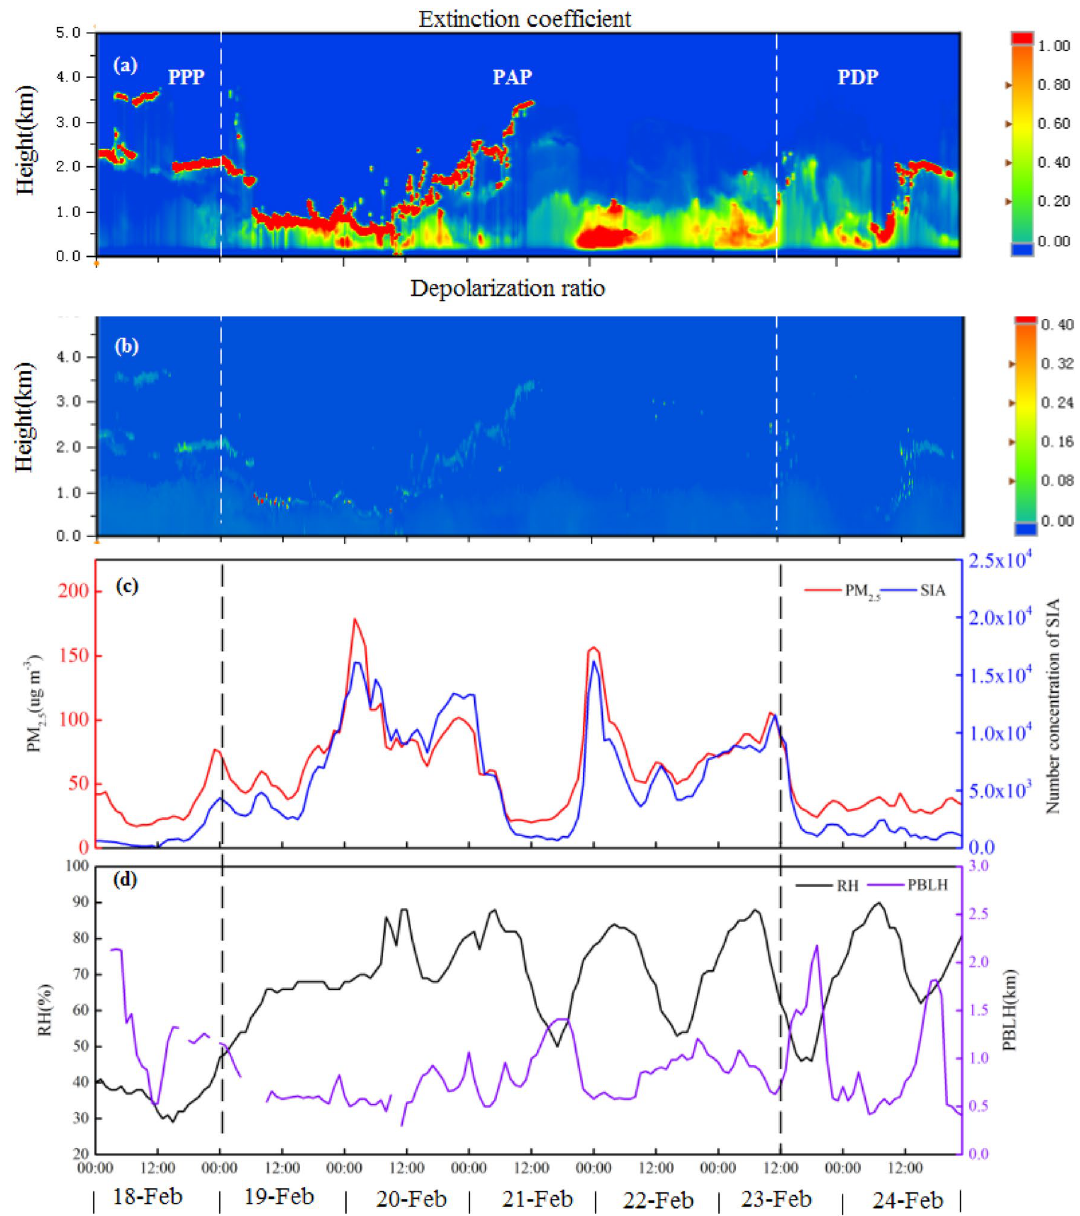
Figure 5. ( a , b ) The time series of the vertical distribution of the extinction coefficient and depolarization ratio of the lidar at 532 nm from February 18 to 24, 2020, respectively, and ( c ) is the time sequence diagram of PM 2.5 mass concentration and secondary inorganic particle number concentration in the same period. ( d ) is a diagram of RH and PBLH from February 18 to 24, reached peak values (179 μg/m 3 for PM 2.5 ). From 00:00, February 20 to 12:00, February 21, the PBLH was slightly uplifted, and wind speed increased. Then, the vertical diffusion conditions improved, and the level of pollut- ants consequently declined. Afterwards, the PBLH decreased, the wind speed decreased from 12:00 to 22:00 on February 21, and the PM 2.5 and SIA levels continued to increase, reaching their peaks. From 0:00 to 21:00 on February 22, the diffusion capability was relatively good, and PM 2.5 and SIAs decreased gradually; however, at 22:00, the near-ground distinction coefficient suddenly increased, and PM 2.5 and SIAs rose and reached a peak value again at 0:00 on February 23. Then, PM 2.5 and SIAs gradually decreased with atmospheric diffusion, and at 0:00 on February 23, the extinction coefficient rose again, while PM 2.5 and SIAs climbed slowly afterwards. Finally, in the PDP, the boundary layer was uplifted, the wind speed became stronger, and the overall atmospheric diffusion condition improved with a relatively small amount of pollutant emissions near the ground; thus, the levels of PM 2.5 and SIA declined in a stepwise manner and were maintained at relatively low levels. It could be concluded that near-ground PM 2.5 accumulated as PBLH significantly decreased; and other factors, including the increase in moisture level, higher RH and local straw burning, also resulted in slight pollution. Additionally, the extinction coefficient would have increased with increasing PM 2.5 . PBLH would have further